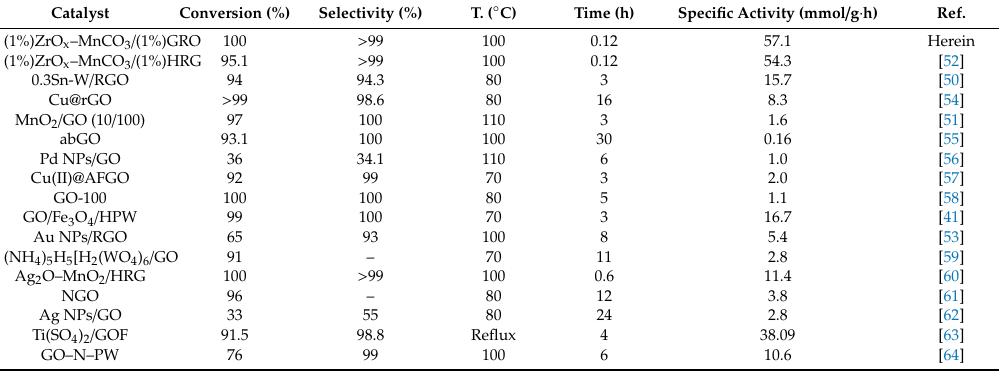
Table 3. Catalytic activity comparisons of di ff erent graphene catalysts for the catalytic oxidation of BzOH to